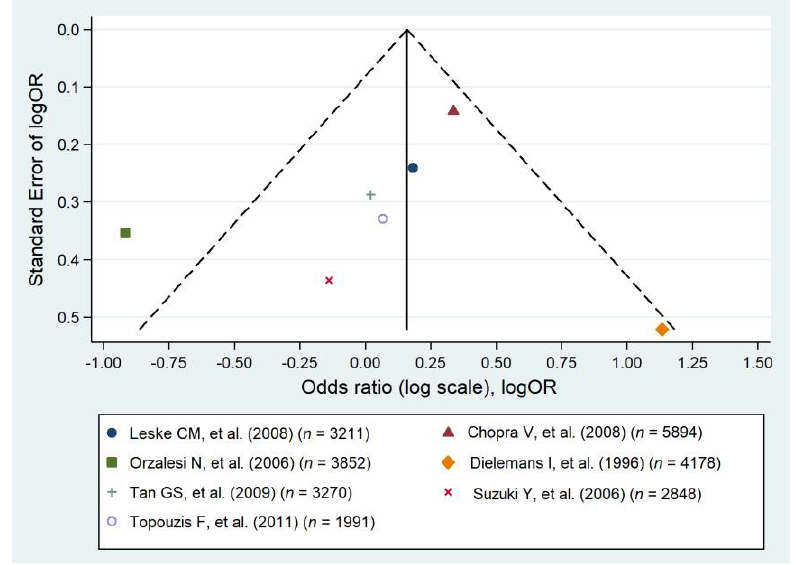
Figure 4. Funnel plot of cohort studies that evaluated diabetes as a risk factor for primary open angle glaucoma [31,32,34,42,46,49,51].